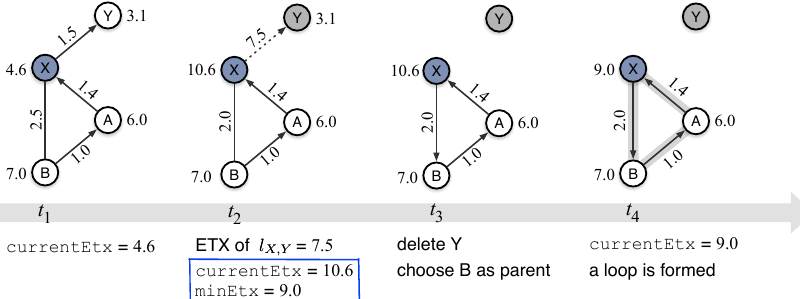
Figure 6. Illustration of a loop caused by conditional expression C3 of CTP which holds true after node Y (parent of X ) is removed out. The numbers near by the node and along the link are the path ETX and the link ETX values,